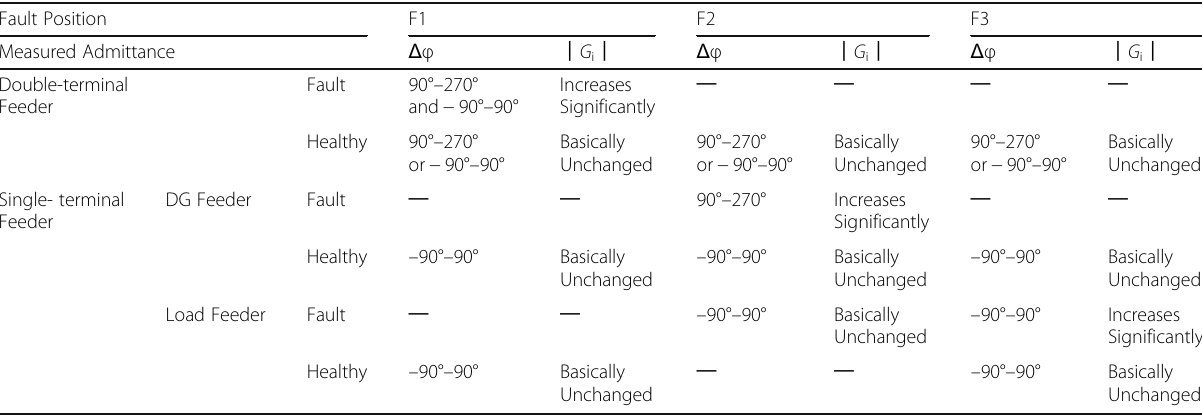
Table 2 Change information of measured admittance Fault